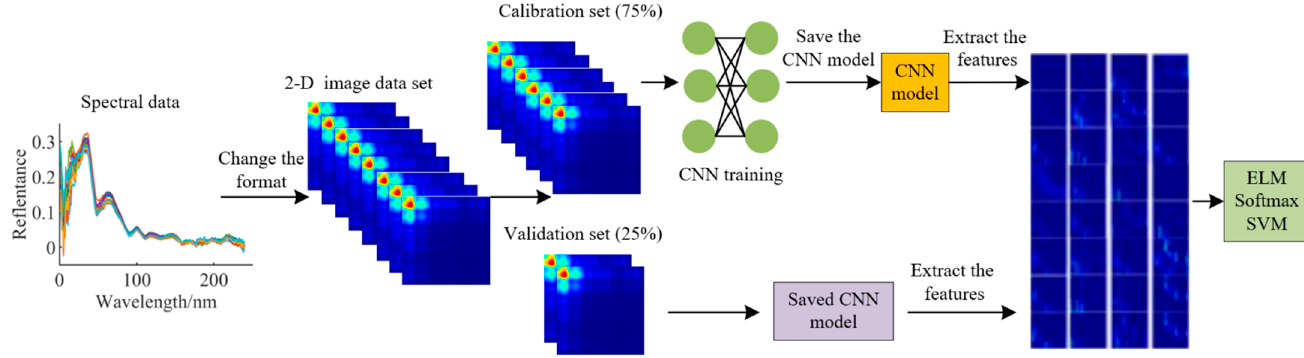
Figure 3. Schematic diagram of data